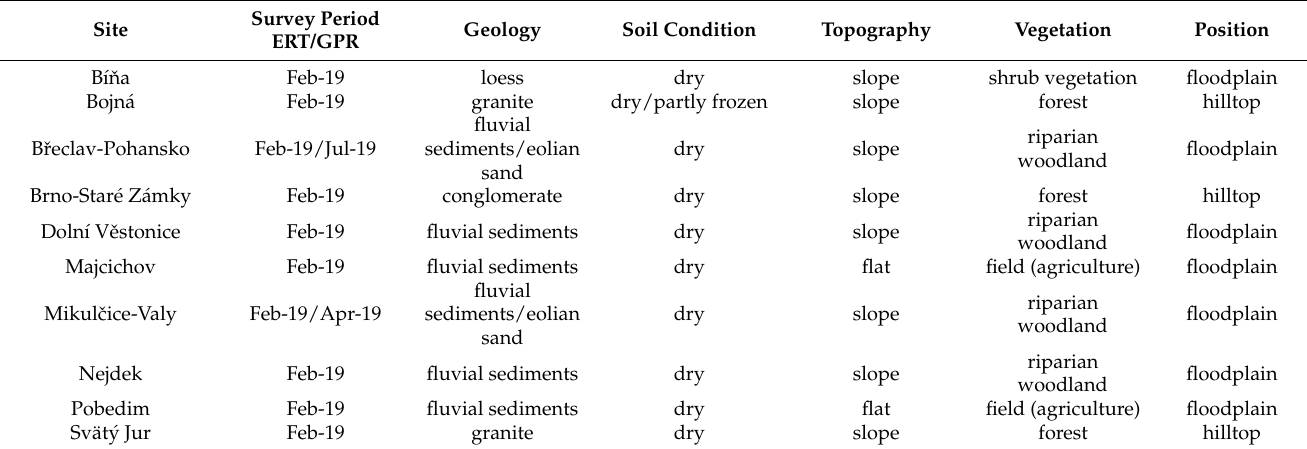
Table 1. Overview of conditions during individual